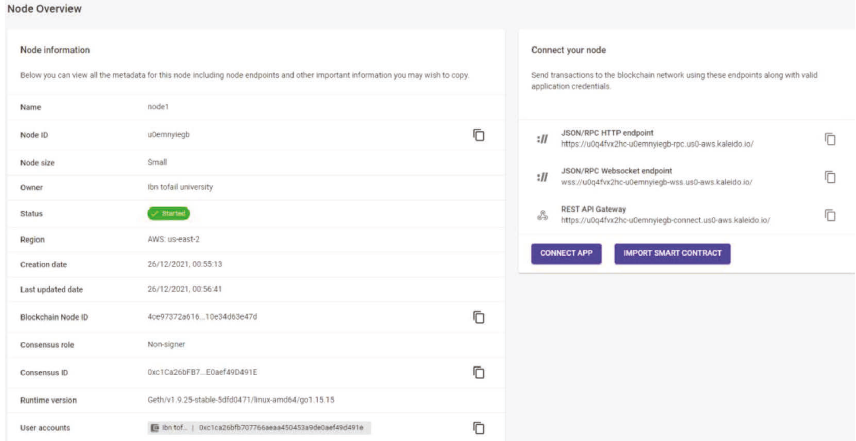
Figure 8: The metadata of node